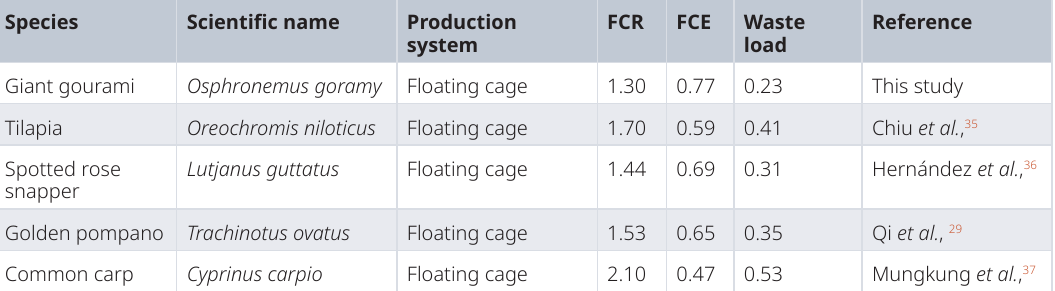
Table 2. Data on FCR, FCE and waste load from producing 1 kg feed in five aquaculture species. Species